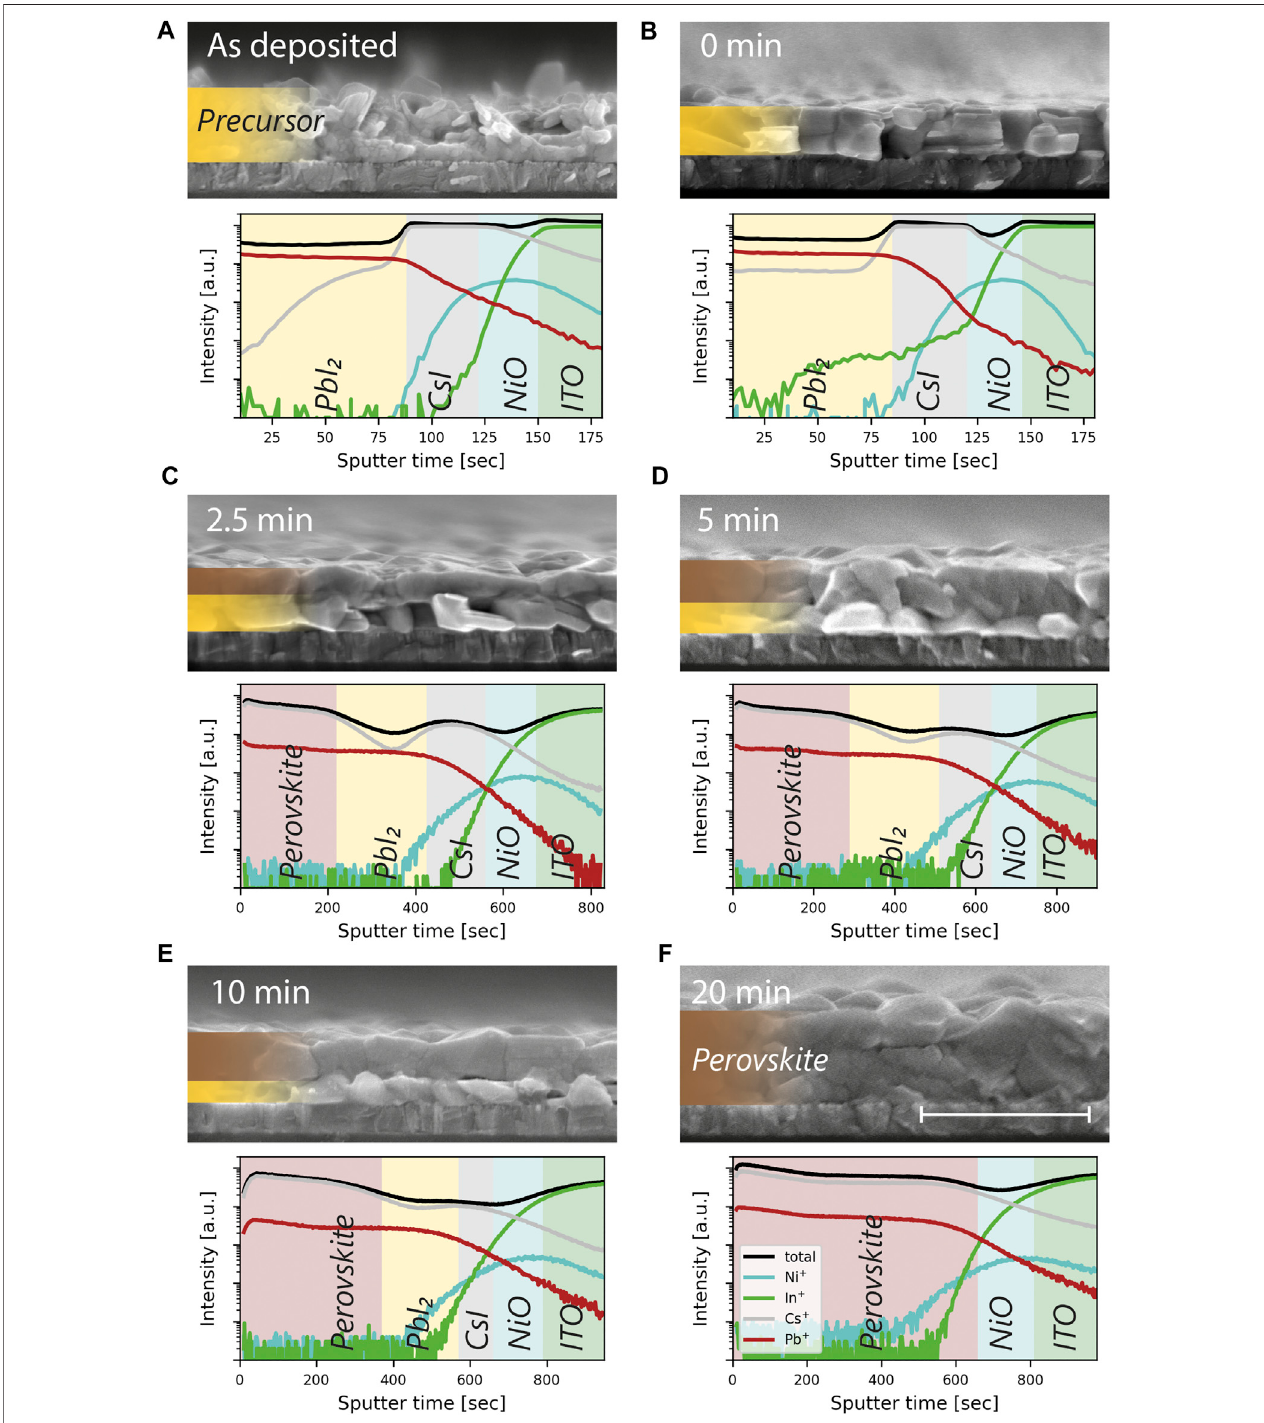
FIGURE4| EvolutionofthereactionfrontanddiffusionofcesiumduringCVDreaction.SIMScompositionalpro fi lesandSEMcrosssectionsofthe (A) asdeposited metalhalideprecursorandintermediatestatesoftheCVDprocessafter (B) 0 min, (C) 2.5 min, (D) 5 min, (E) 10 minand (F) 20 minofreaction.TheshadingsintheSIMS pro fi les are meant as a guide to the eye and do not represent clear boundaries of the different layers. The scale bar for the SEM images corresponds to 1 μ m and the legend in (F) applies to all SIMS pro fi les.